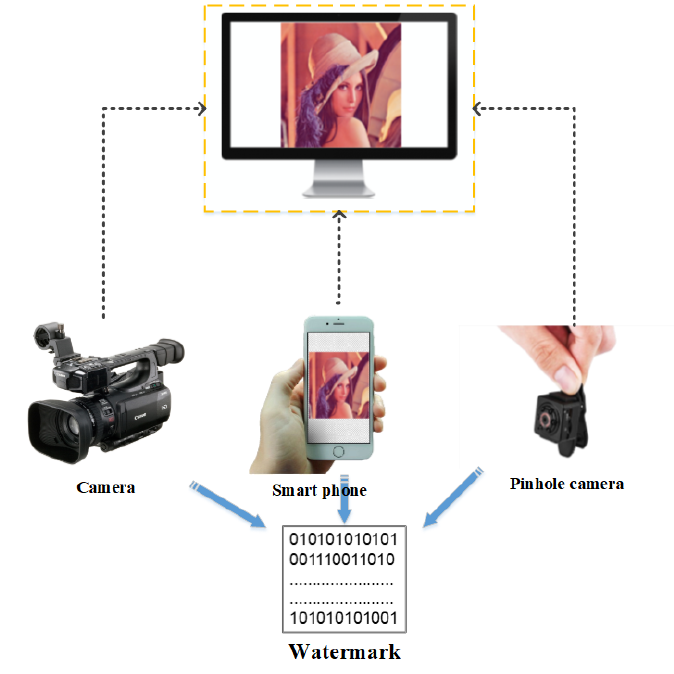
Figure 1. Schematic diagram of screen